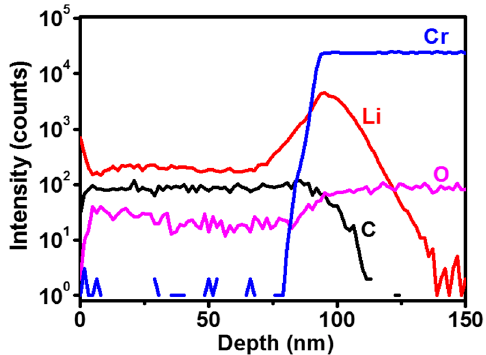
Figure 3. Secondary ion mass spectroscopy (SIMS) depth profiles of C, Li, Cr, and O species in NCD/Cr/LNO films.